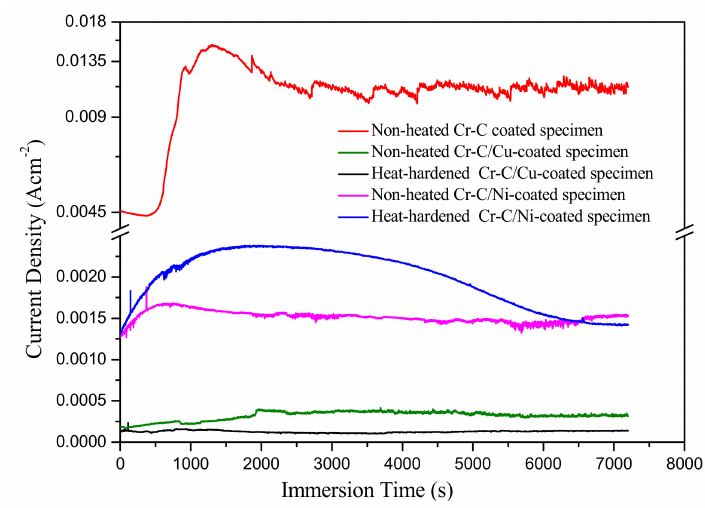
Figure 5. Variation of anodic current densities of the Cr–C-, Cr–C / Ni- and Cr–C / Cu-coated samples during potentiostatic etching at 0 V.